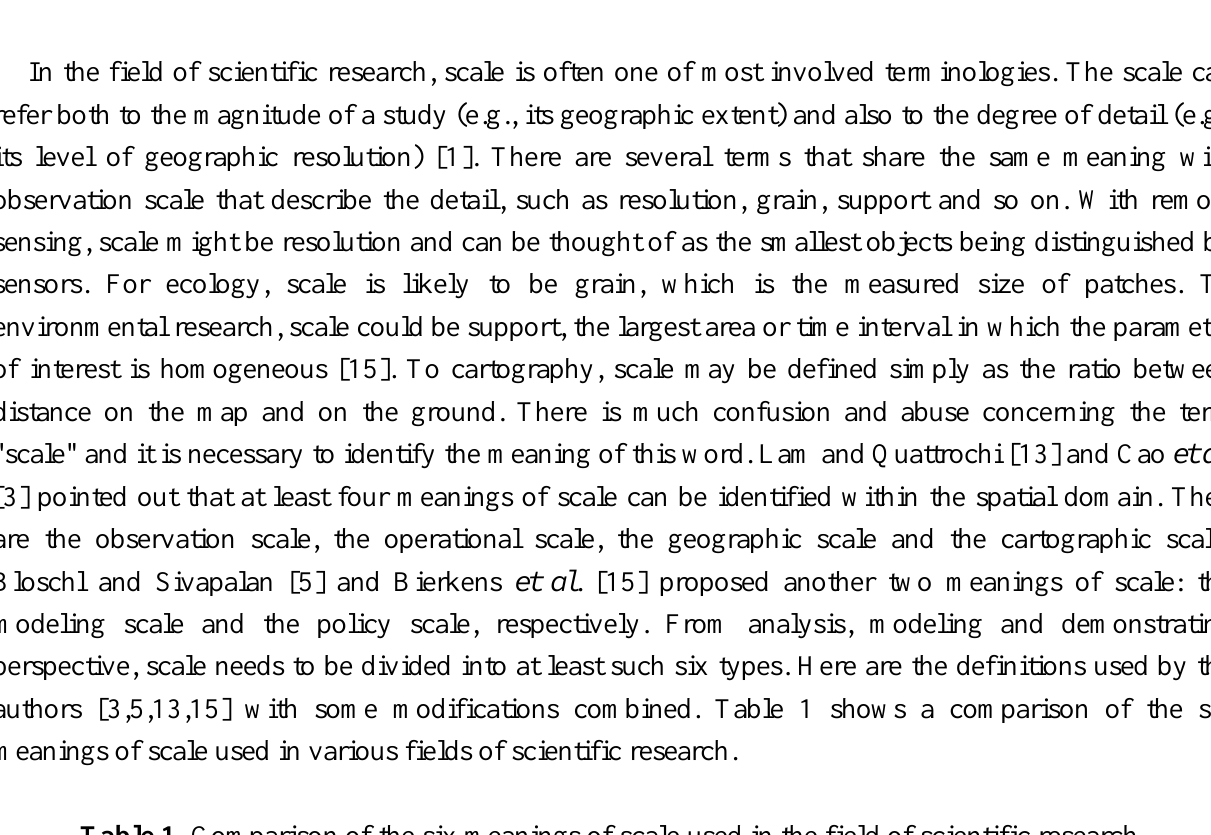
Table 1. Comparison of the six meanings of scale used in the field of scientific research.